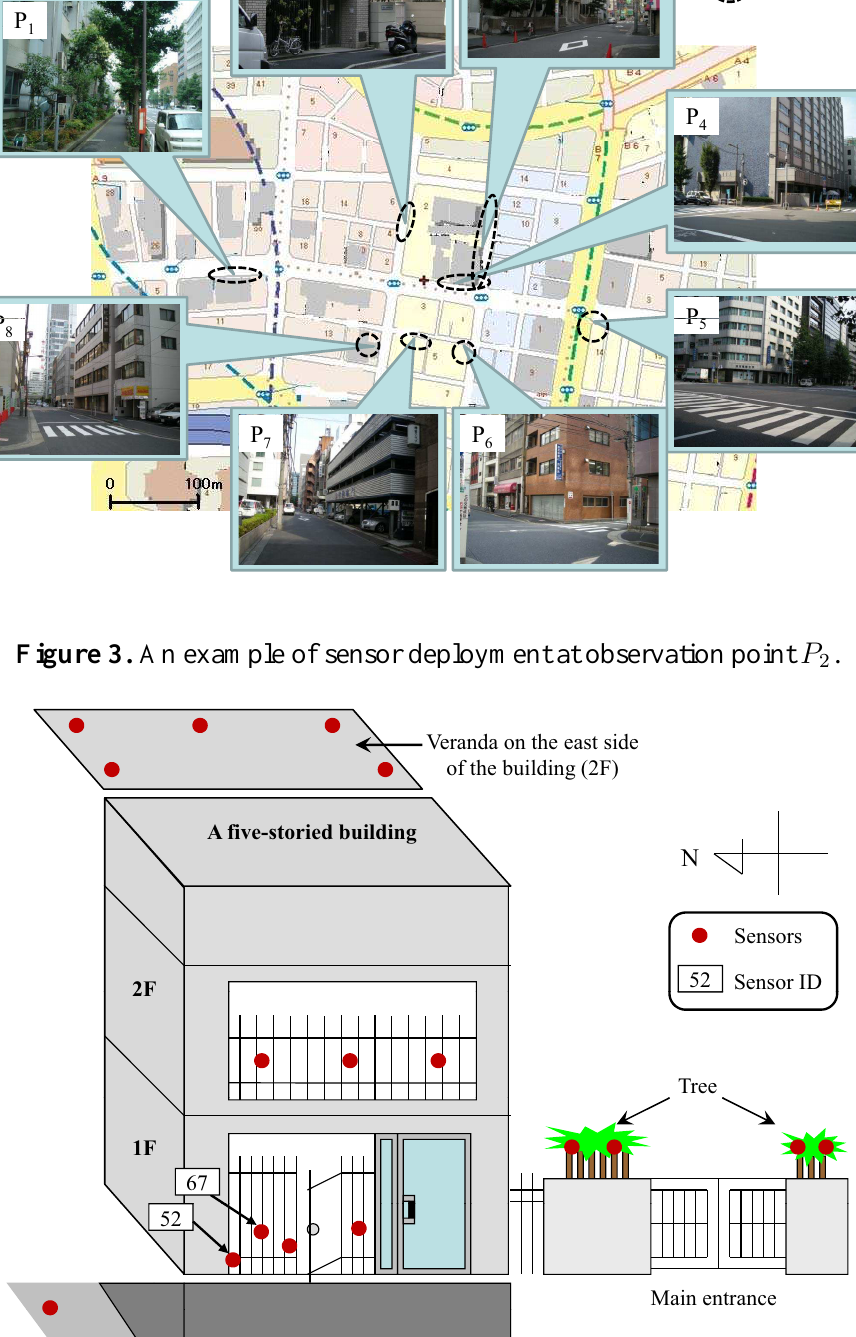
Figure 2. Eight installation points in 250m-by-430m area for 200 sensors.